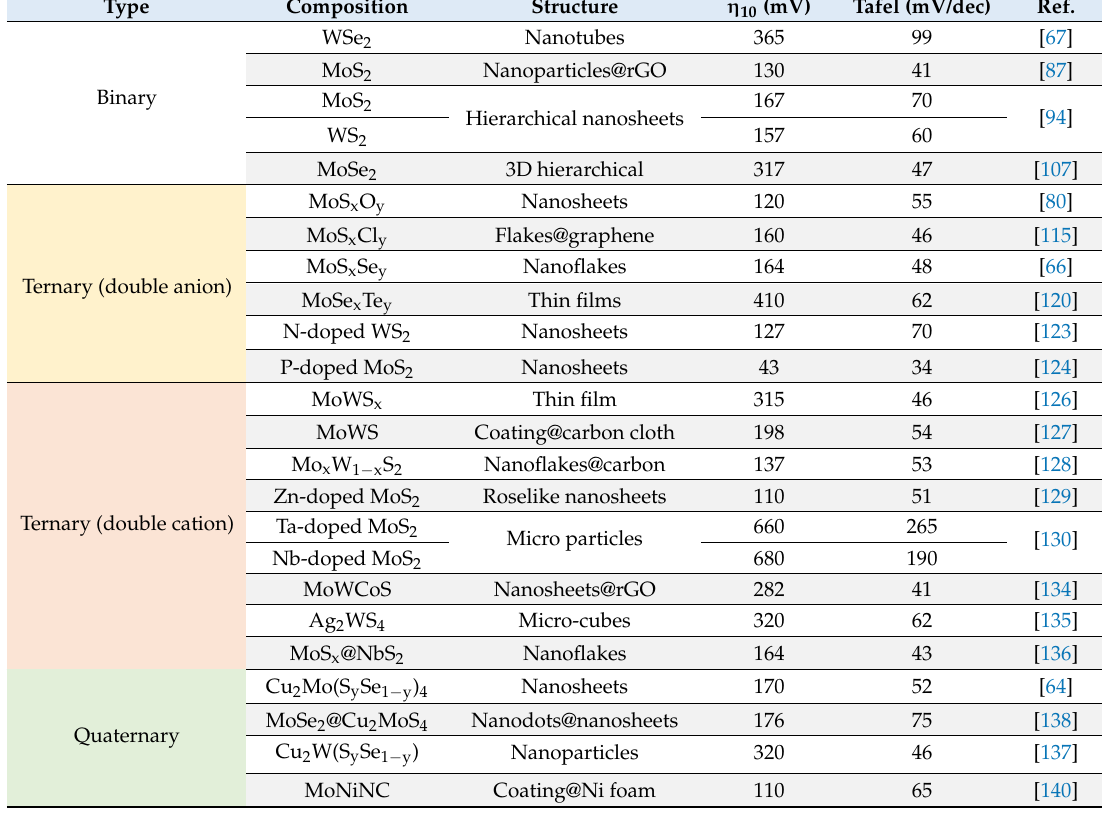
Table 1. Performance data of various catalysts, showing the overpotential at 10 mA cm − 2 ( η 10 ) and Tafel